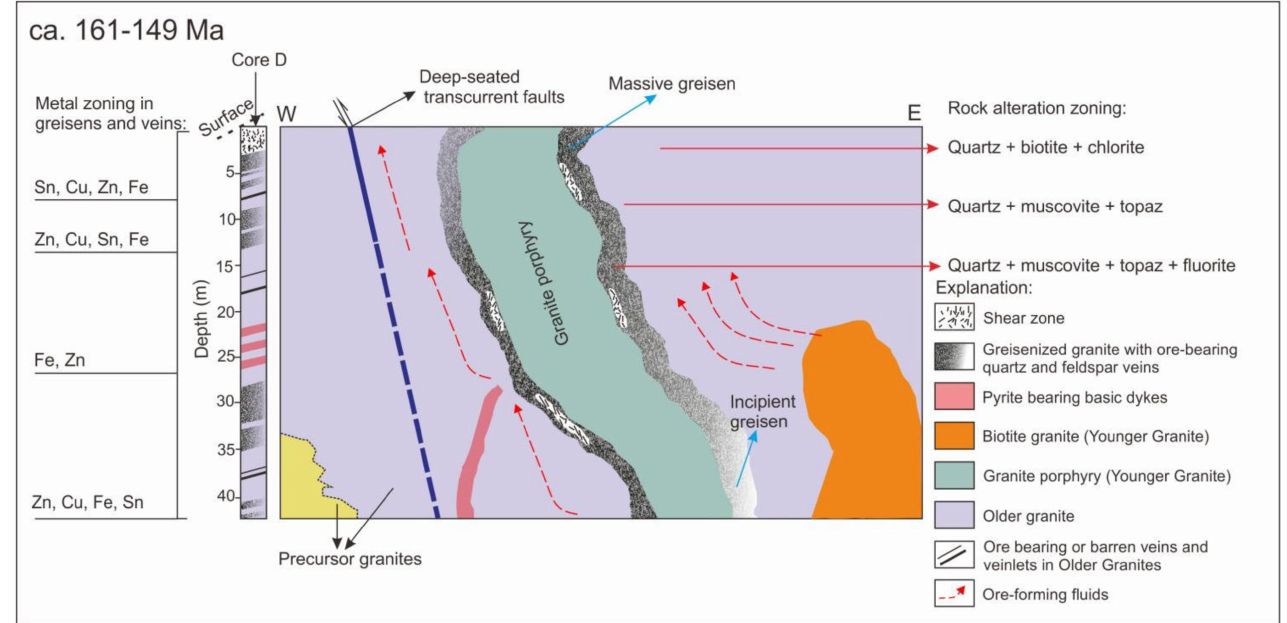
Figure 15. Simplified magmatic-metallogenic model (not to scale) within ca. 161 to 149 Ma after over 400 Ma hiatus, pressure released from reactivated transcurrent fault triggered partial melting, followed by forceful emplacement of the Jurassic granite porphyry, which sheared the Older Granites (modified after [59,99]). Mineralized fluids that escaped from the roof zone of biotite granite intrusion moved through the shears, altered, and mineralized the precursor rocks around the vicinity of the